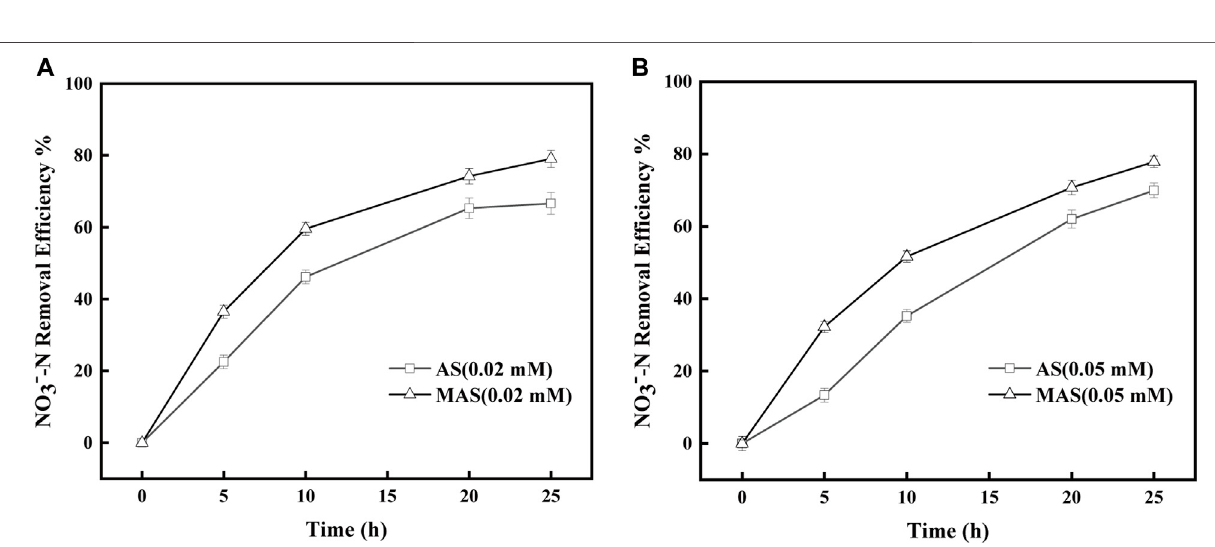
Frontiers in Chemistry |